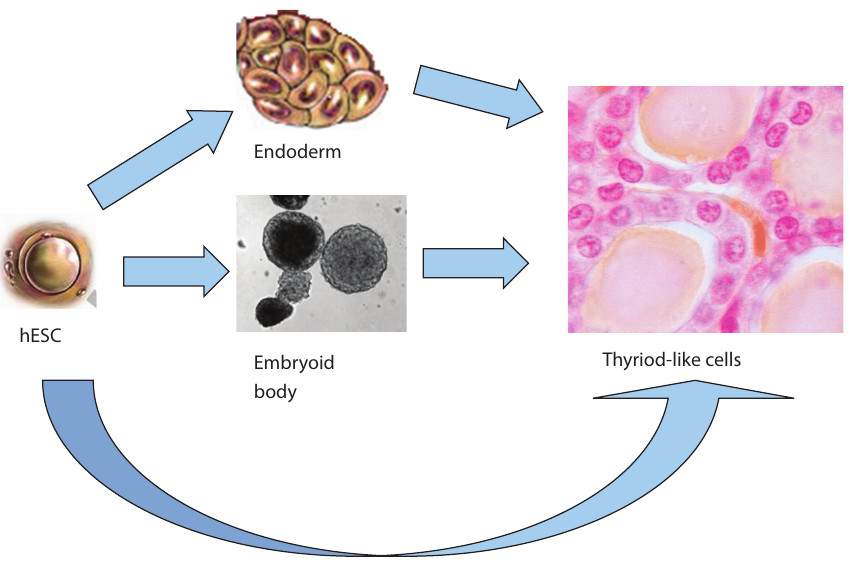
Figure 1: Proposed patterns of directed di ff erentiation of human embryonic stem cells to thyroid cell line.